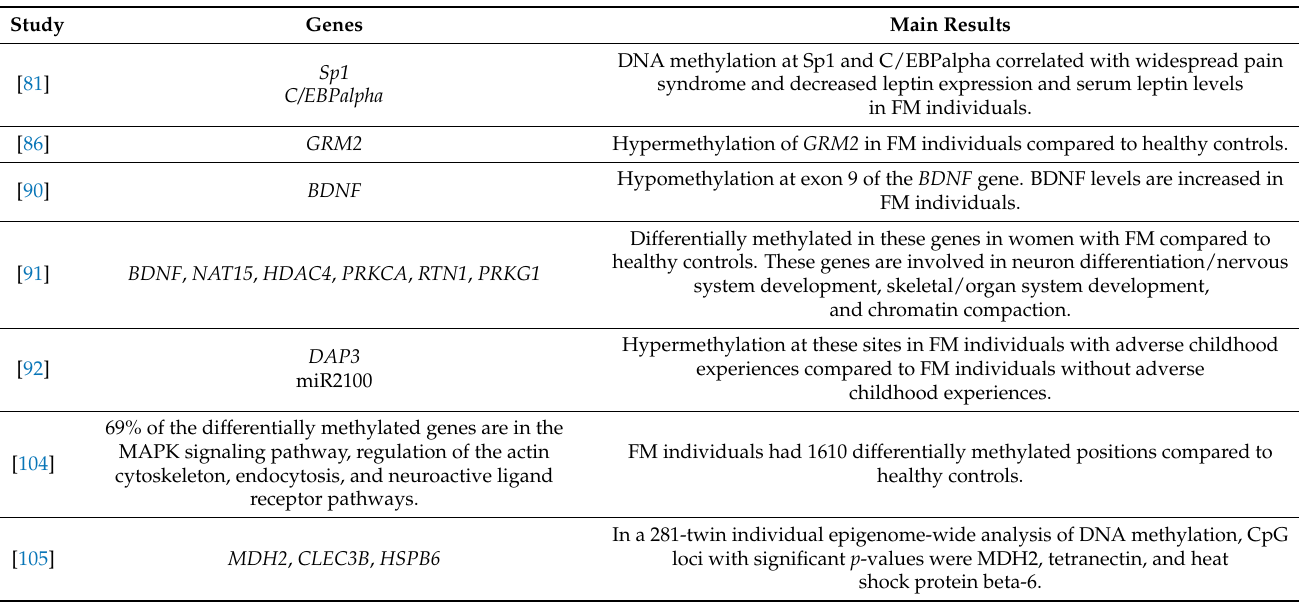
Table 4. Association of DNA methylation changes and